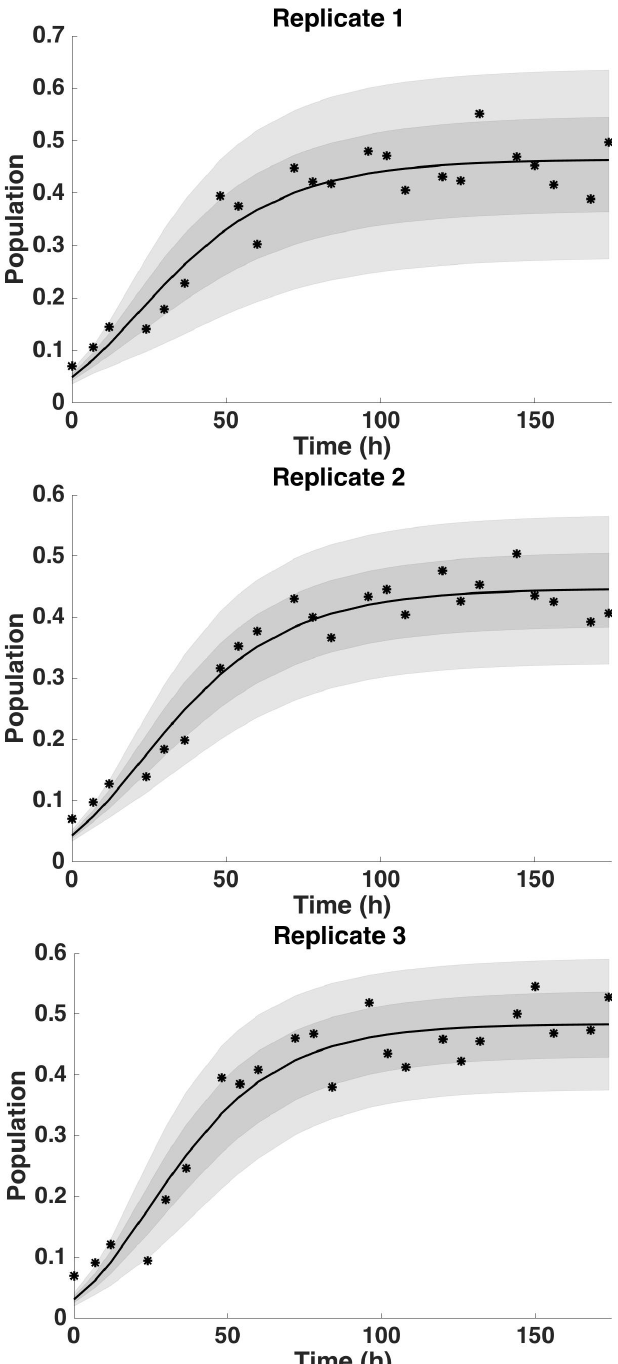
Figure 3. Plots of forward solutions for the Gompertz curve for the three replicates of the data. Replicate one is on top and three is on the bottom. The lighter and darker shades of grey represent the 95% and 68% confidence bars on the model solution, respectively. The algae population is represented as cells × 10 7 /L. Data points are shown as